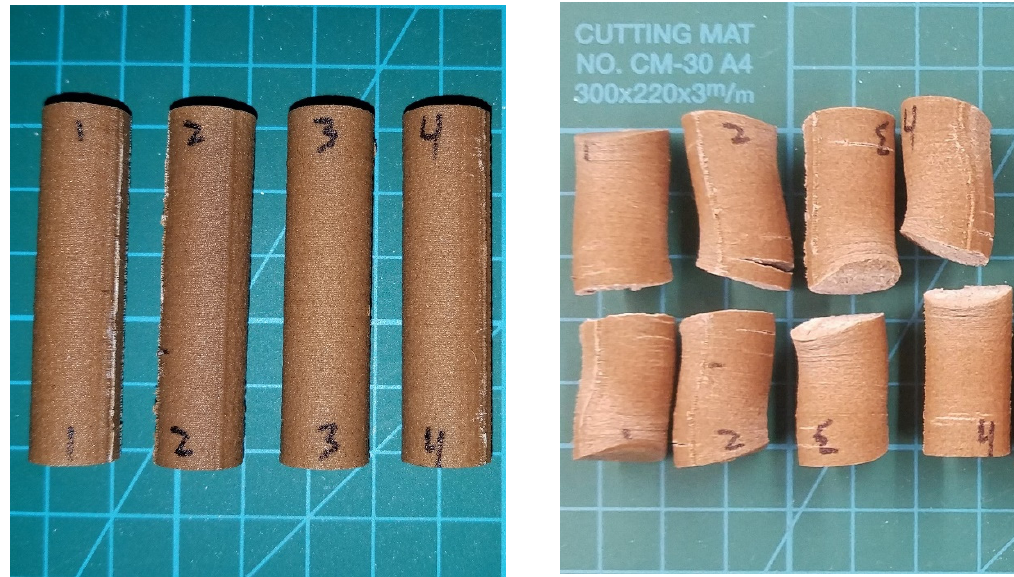
Figure 4. Example Compression Specimens Before ( Left ) and After ( Right ) Testing.